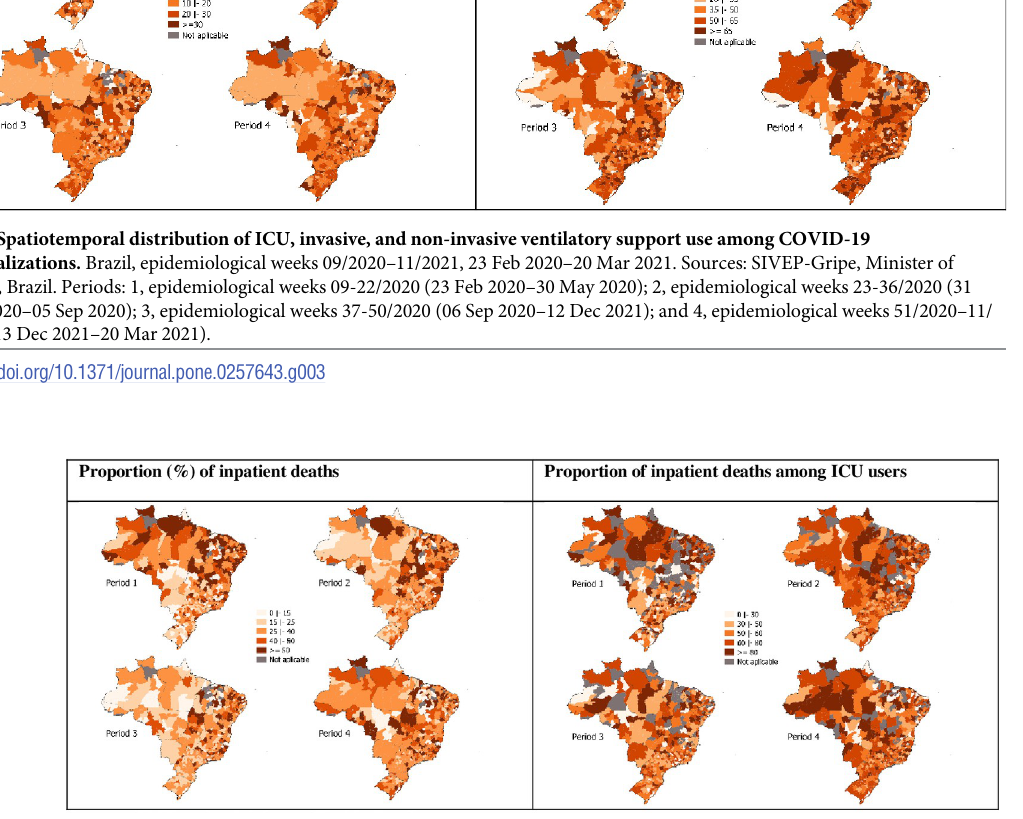
Fig 4. Spatiotemporal distribution of COVID-19 inpatient general and ICU mortality. Brazil, epidemiological weeks 09/2020–11/2021, 2020–11/2021, 23 Feb 2020–20 Mar 2021. Sources: SIVEP-Gripe, Minister of Health,